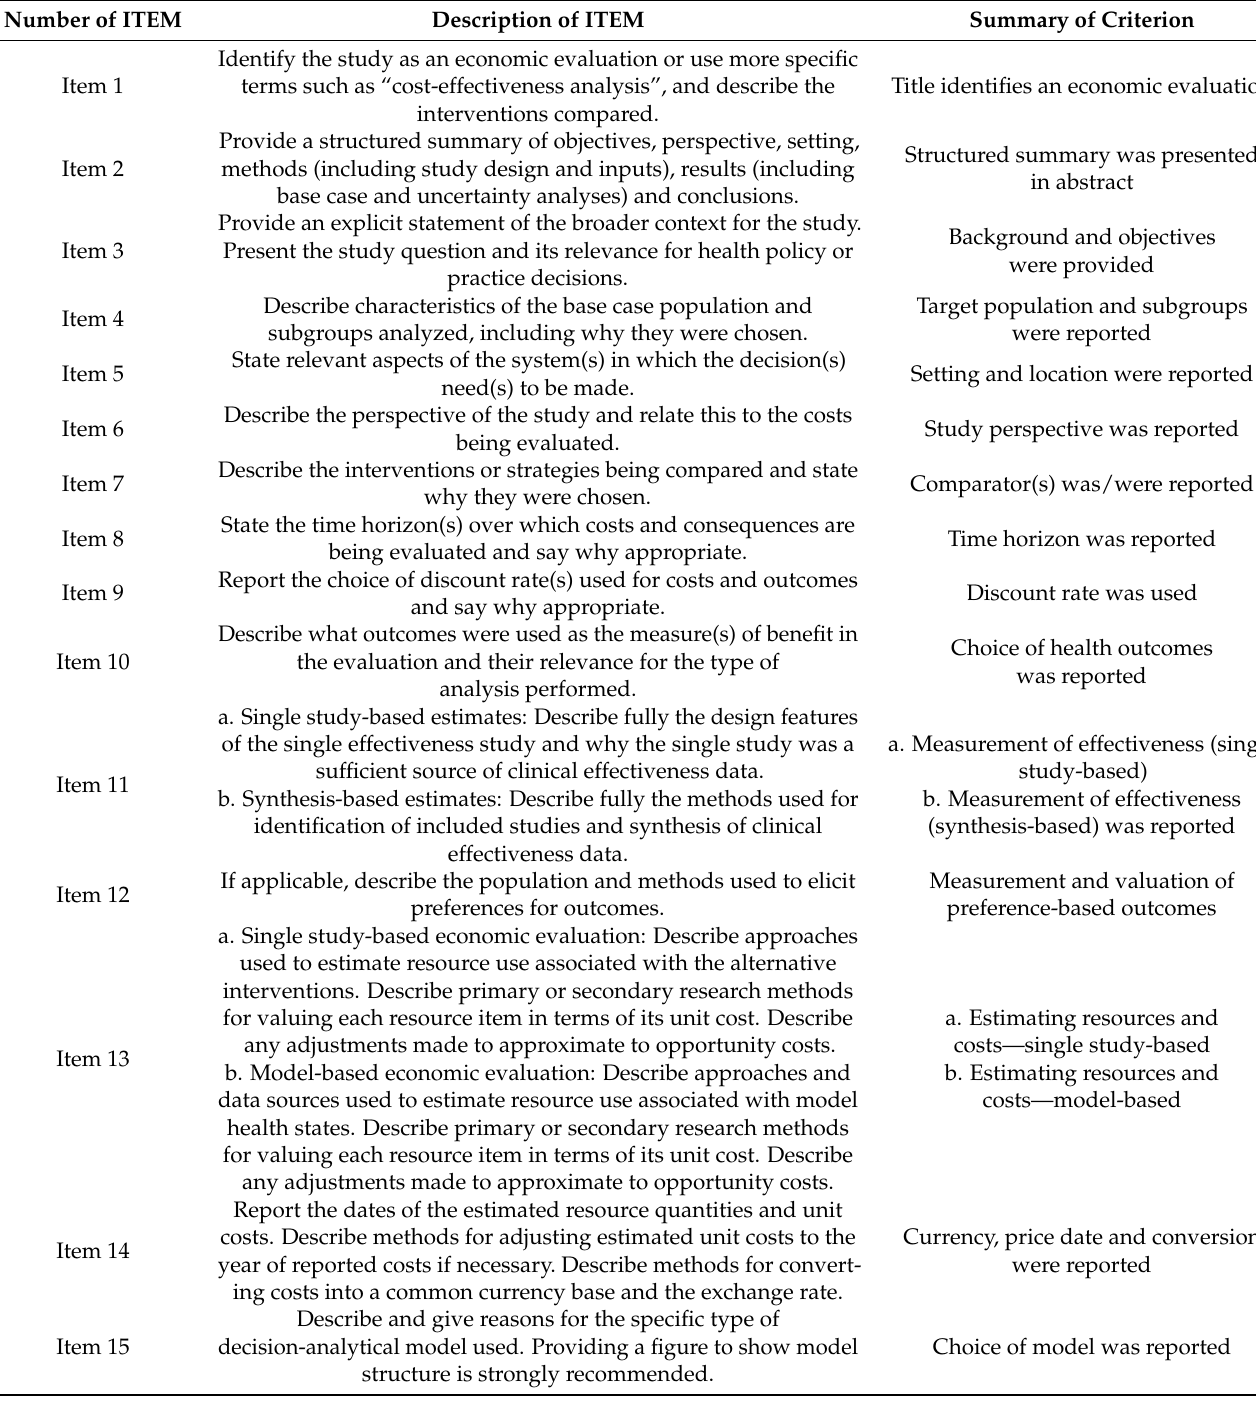
Table A6. CHEERS checklist—items to include when reporting economic evaluation of health